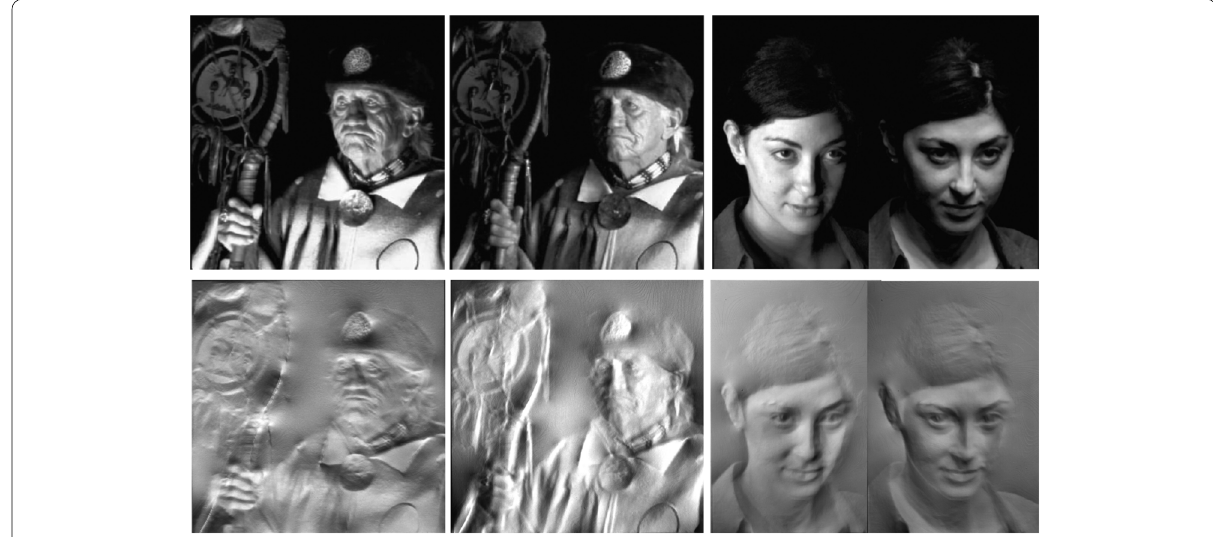
Fig. 18 The bas‑reliefs fabricated by Alexa and Matusik [35] have multiple appearances under different light conditions